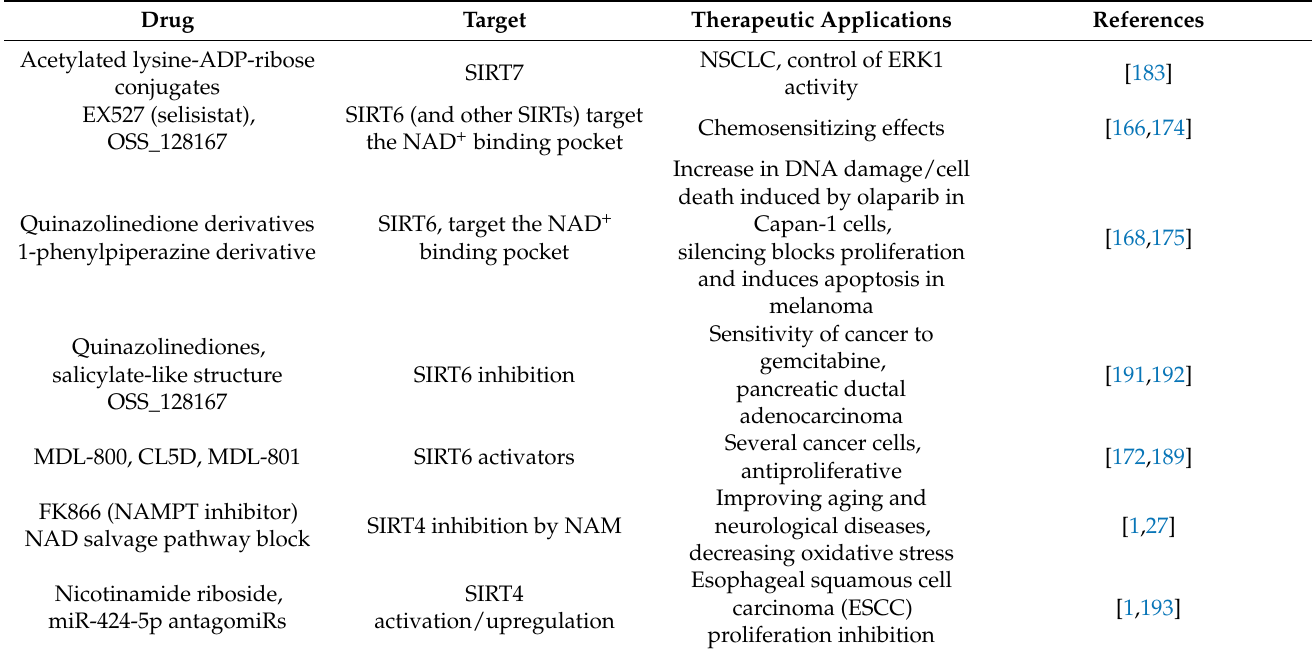
Table 5. MARylating sirtuins: inhibitors and